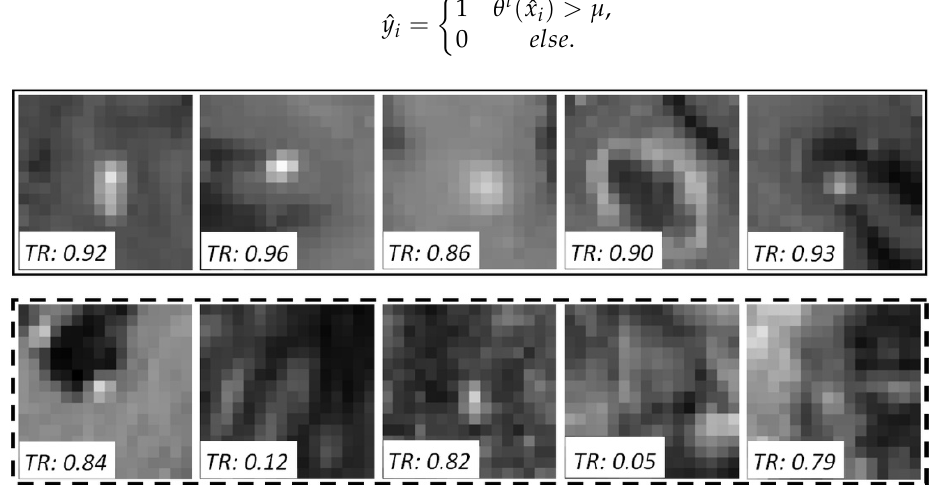
Figure 4. Mid-axial slices of an example pseudo-labeled batch of five pairs. The upper and lower rows show the positive and negative samples respectively. The response threshold ( µ ) is 0.85, and the teacher model responses (TR = θ t ( ˆ x i ) ) are given with the